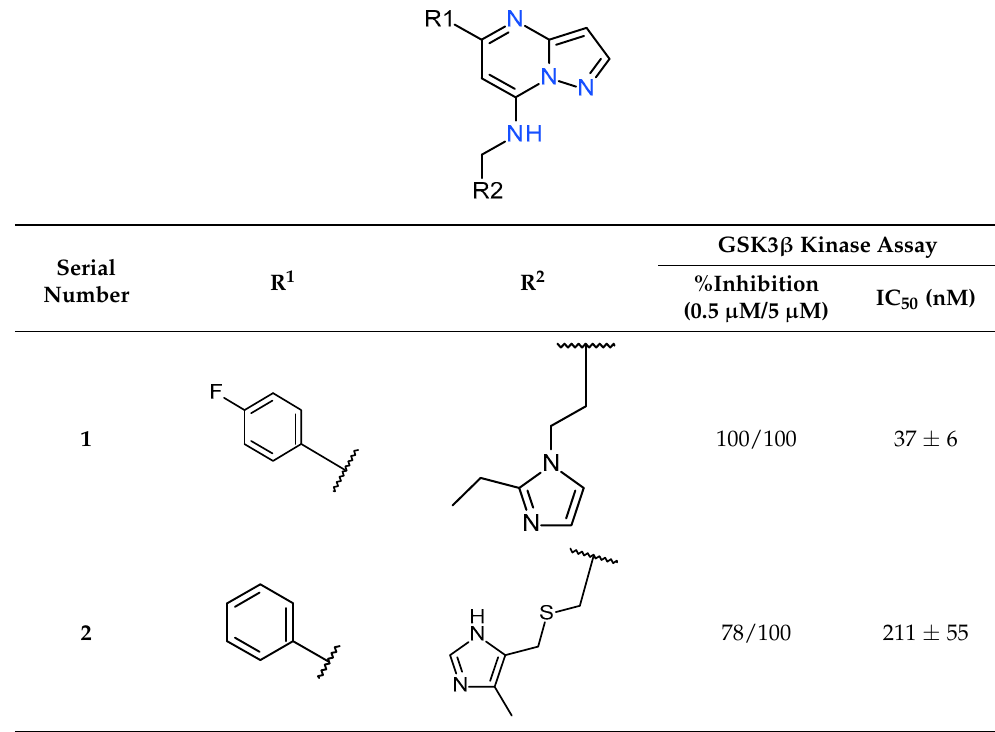
Table 1. GSK3 β inhibitory effects of derivatives of pyrazolo[1,5-a]pyrimidine.